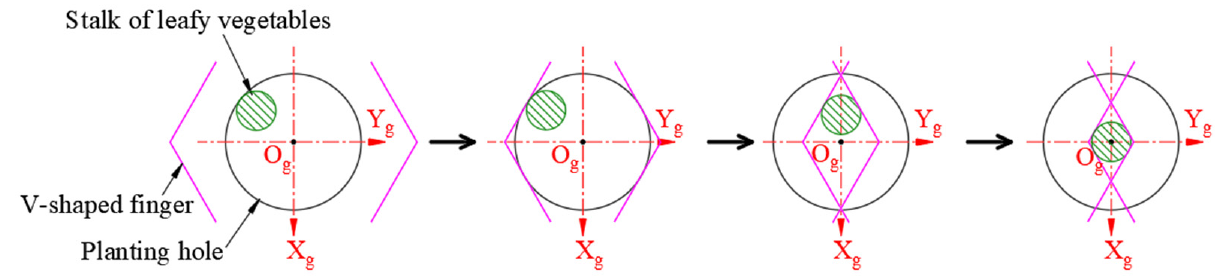
Figure 4. Clamping process of the two V-shaped fingers on the stalk of leafy vegetables. In order to adjust the center of inclined hydroponic Chinese kale to the center of the planting hole, suitable torque should be applied to the kale grabbable area, and interference of the two fingers needs to be avoided during the clamping process. For this reason, the two V-shaped cross fingers were designed as a three-layer structure along the Z g axis, as shown in Figure 5. One layer is a solid structure single finger. The other two layers are formed by the second finger’s hollow structure through which the single finger passes in the clamping process. In Figure 5, P 1 , P 2 , and P 3 represent the single-finger contact surface with the grabbable area of the hydroponic Chinese kale and the upper and lower layers of the double-finger contact surface with the grabbable area of the hydroponic Chinese kale, respectively.